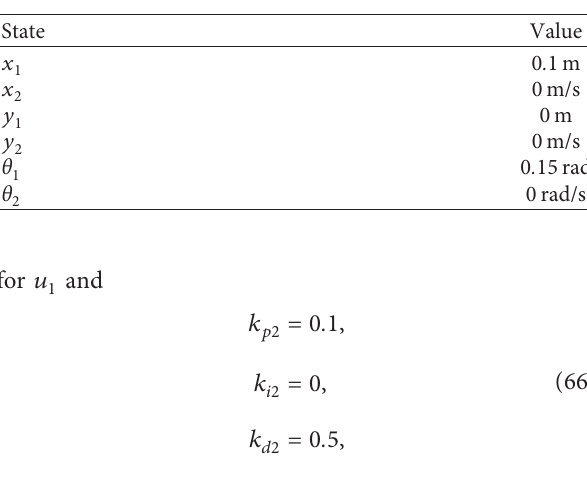
Table 2: Initial